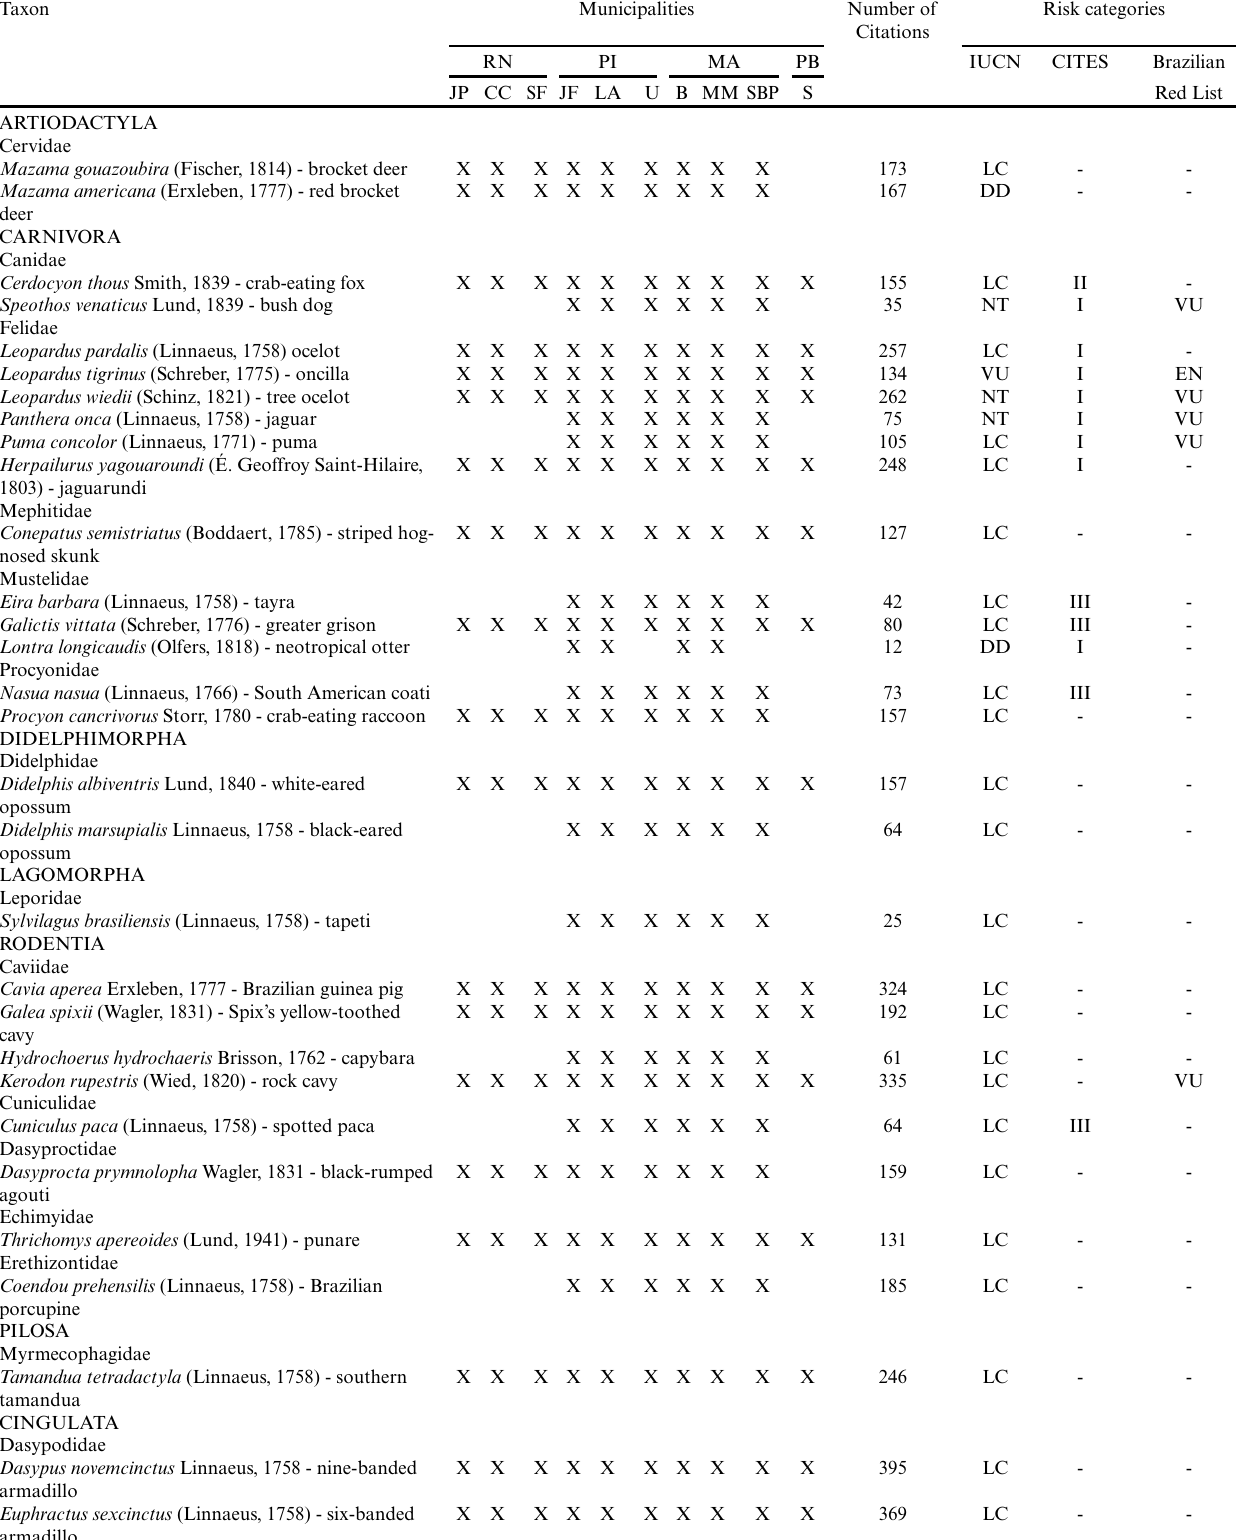
Table 2 . Mammal species cited by respondents in each municipality surveyed and their risk